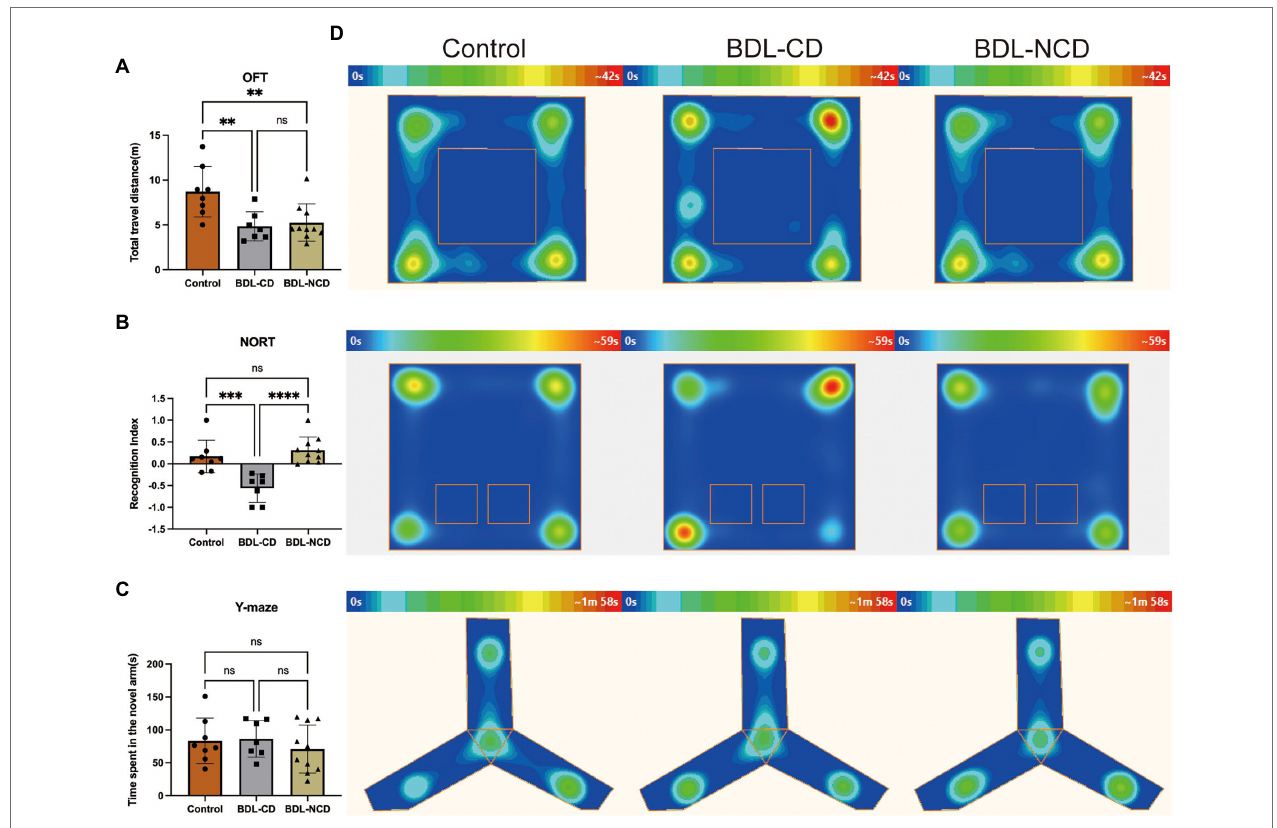
FIGURE 2 | Cholestatic liver disease-related cognitive dysfunction in mice. (A) Total travel distance of OFT at day 8. (B) Recognition index of NORT at day 9. (C) Y-maze test at day 10. (D) Heat map of the group center in the OFT, NORT, and Y-maze tests. BDL, Bile Duct Ligation; OFT, Open Field Test; and NORT, Novel Object Recognize Test. Data are presented as the mean ± SEM. ** p < 0.01; *** p < 0.001; **** p < 0.0001; and ns, not